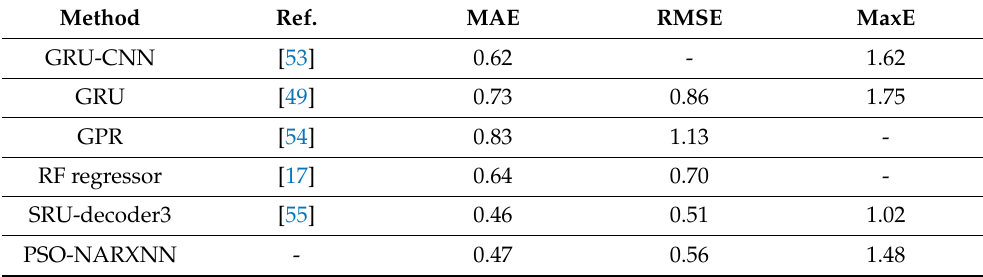
Table 6. Comparison with other similar